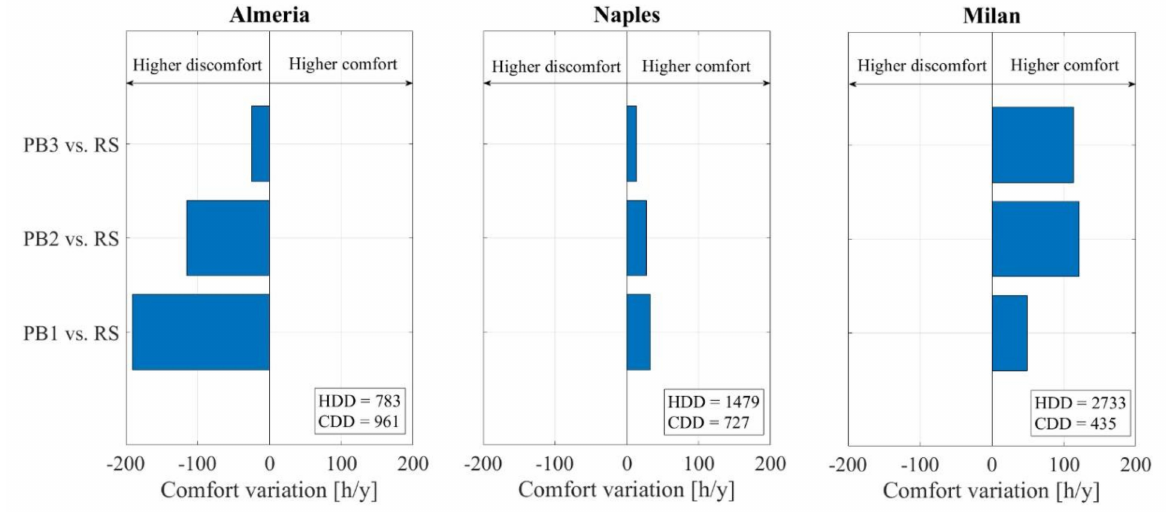
Figure 25. Thermal comfort variation in all the proposed dwellings compared to reference dwelling (reprinted from [120], with permission from publisher).